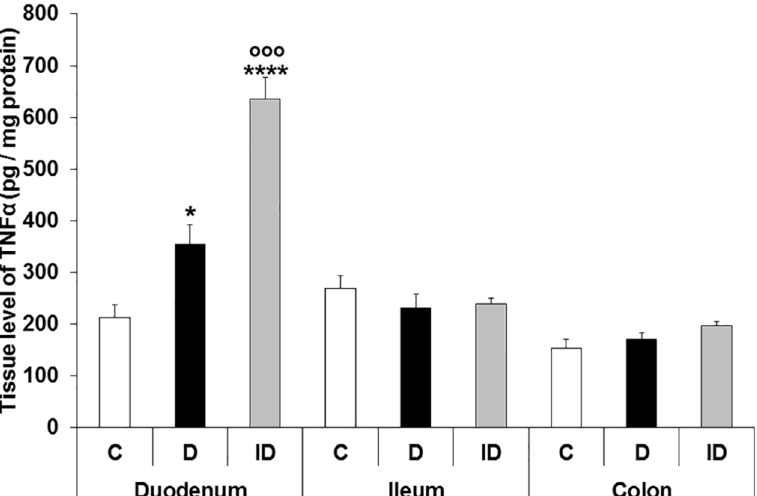
Figure 6. The tissue level of TNF α in the homogenates of intestinal smooth muscle layers, including the myenteric plexus, from the different gut segments of control, diabetic and insulin-treated diabetic rats. The tissue level of TNF α was markedly increased in the duodenum of diabetic animals, which was further enhanced in the insulin-treated diabetics. Data were expressed as means ±